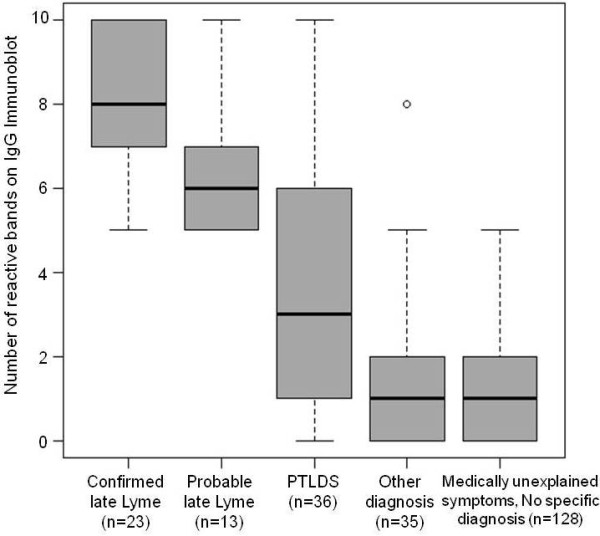
Box plots of the number of reactive IgG bands on commercially available serologic tests for antibodies toBorrelia burgdorferiby disease group (n = 235).